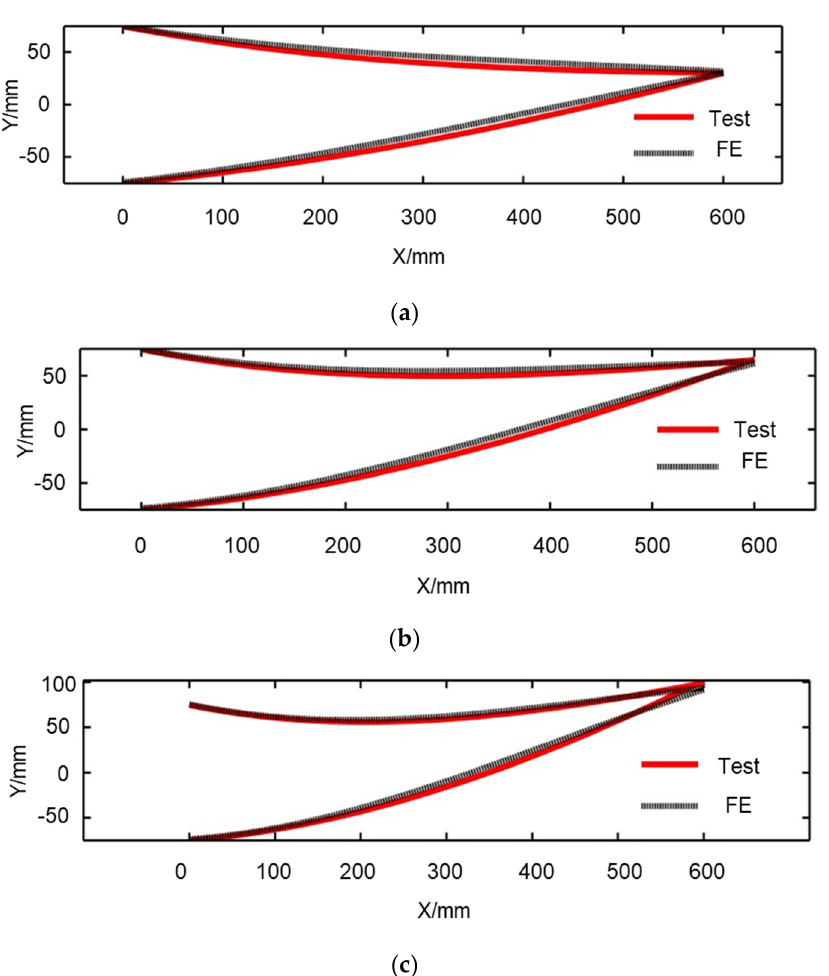
Figure 9. Simulated and measured shape: ( a ) deflection angle is 3°; ( b ) deflection angle is 6°; ( c ) deflection angle is 9° .